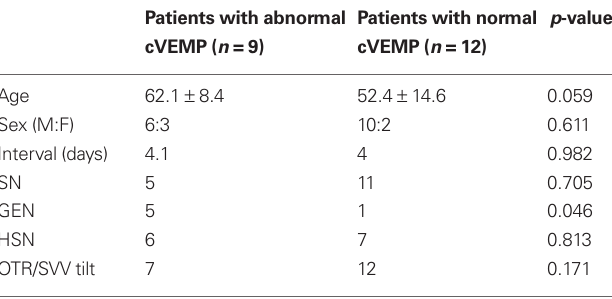
Table 3 | Comparison of demographics and associated findings between the